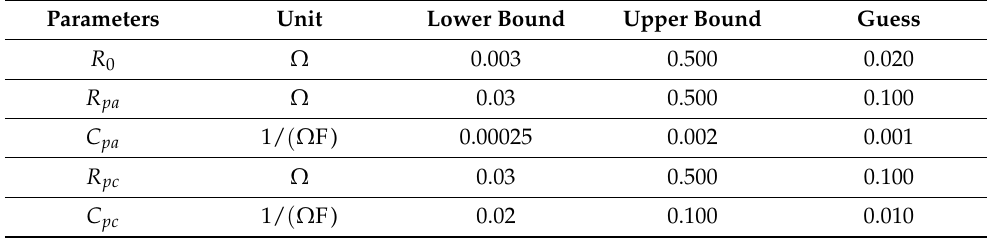
Table 1. NLLS Boundaries and Initial